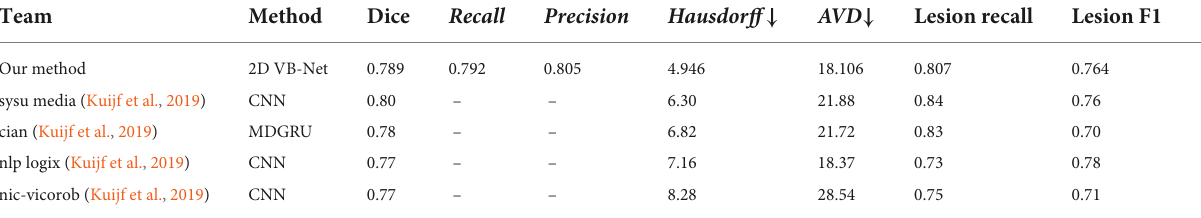
TABLE 2 Performance of the algorithms for WMH segmentation on the challenge public dataset. Team